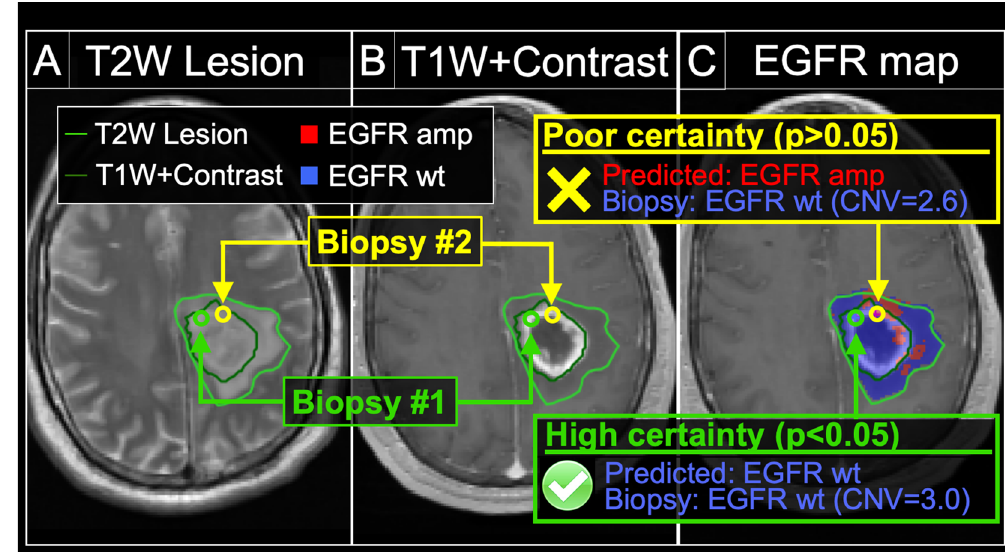
Figure 4. Model uncertainty can inform the likelihood of achieving an accurate radiogenomics prediction for EGFR amplification status. We obtained two separate biopsies (#1 and #2) from the same tumor in a patient with primary GBM. The ( A ) T2W and ( B ) T1+C images demonstrate the enhancing (dark green outline, T1W+Contrast) and peripheral non-enhancing tumor segments (light green outline, T2W lesion). The ( C ) radiogenomics color map shows regions of predicted EGFR amplification (amp, red) and EGFR wildtype (wt, blue) status overlaid on the T1+C images. For biopsy #1 (green circle), the radiogenomics model predicted EGFR wildtype status (blue) with high certainty, which was concordant with biopsy results (green box). For biopsy #2 (yellow circle), the radiogenomics model showed poor certainty (i.e., high uncertainty), with resulting discordance between predicted (red) and actual EGFR status (yellow